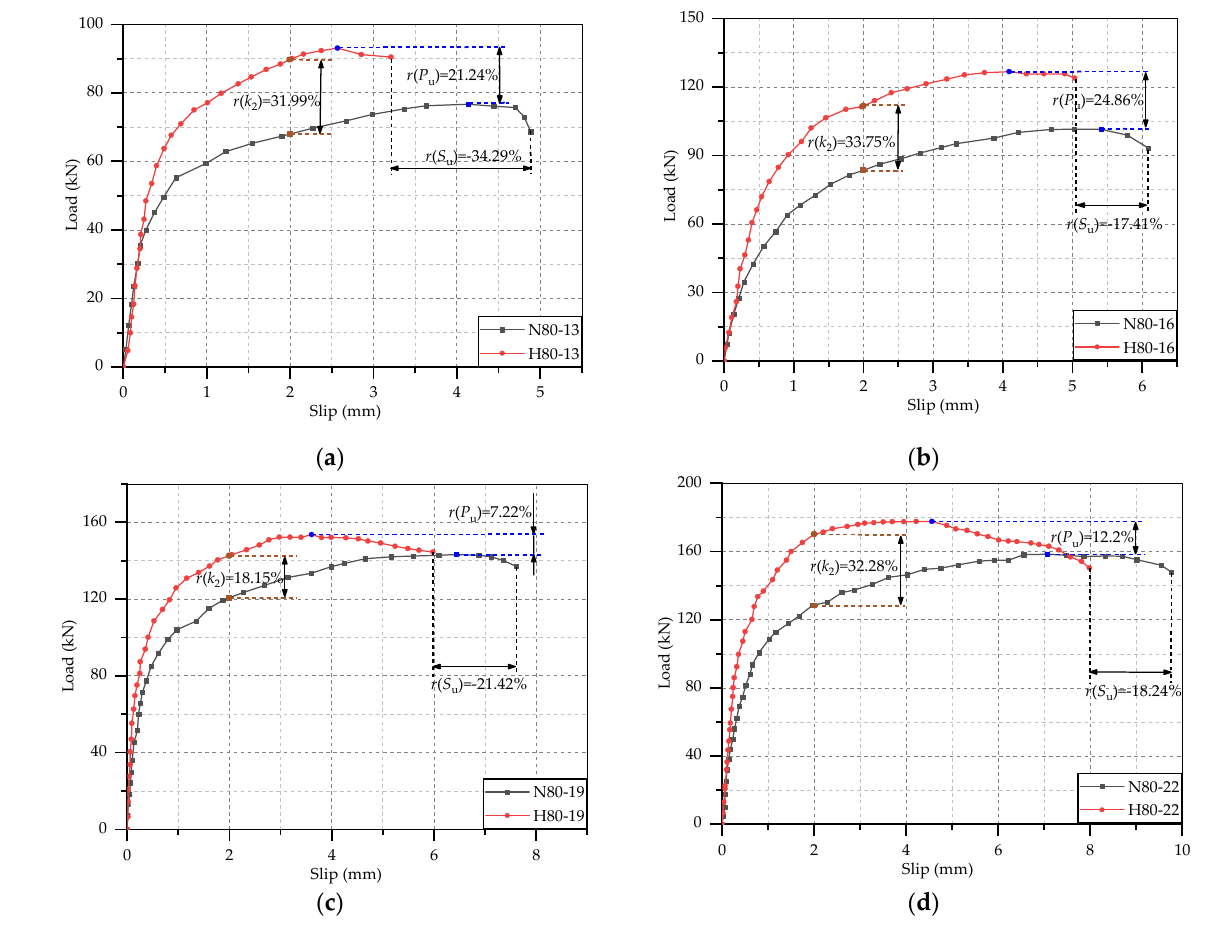
Figure 5. Effect of concrete type: ( a ) d = 13 mm, h = 80 mm; ( b ) d = 16 mm, h = 80 mm; ( c ) d = 19 mm, h = 80 mm; ( d ) d = 22 mm, h = 80 mm.